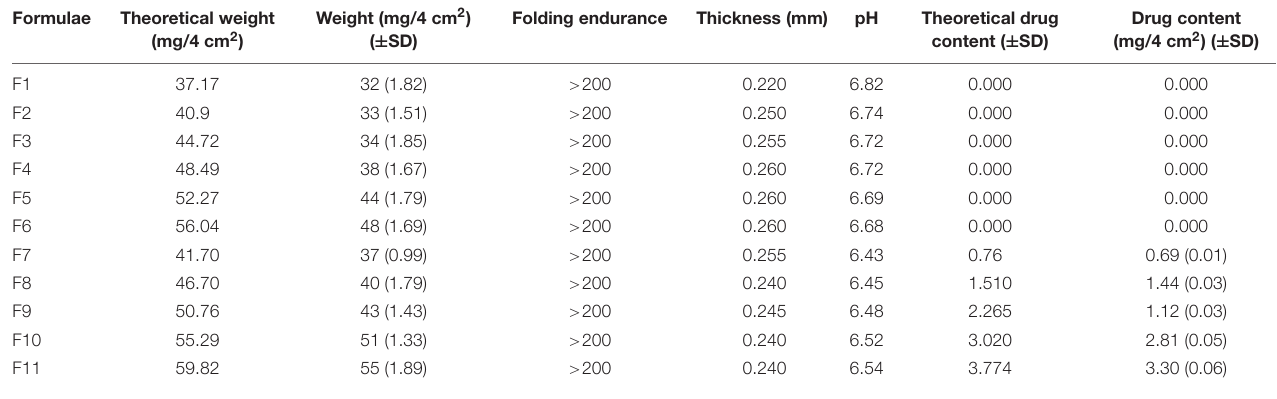
TABLE 3 | Physicochemical properties of the prepared water-soluble films.